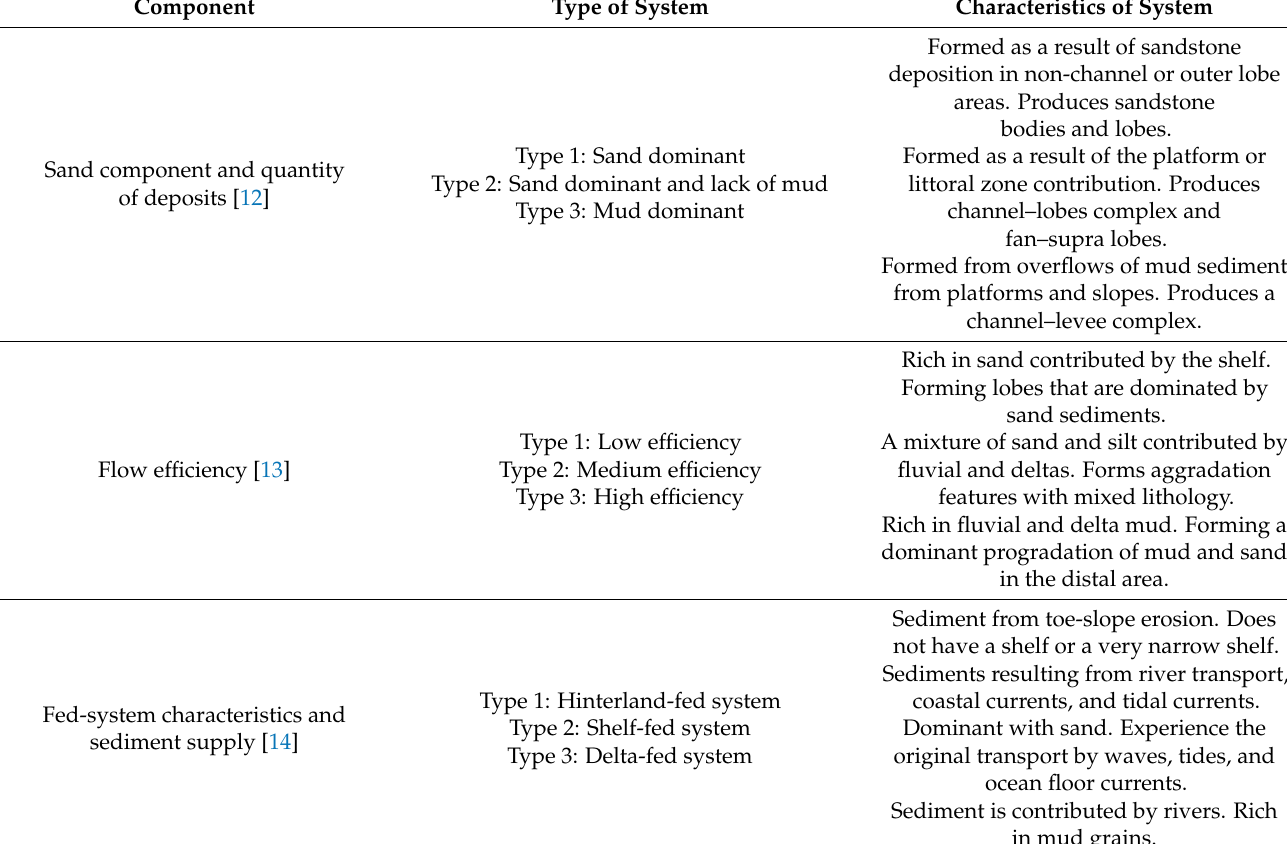
Table 1. Summary of characteristics and depositional system